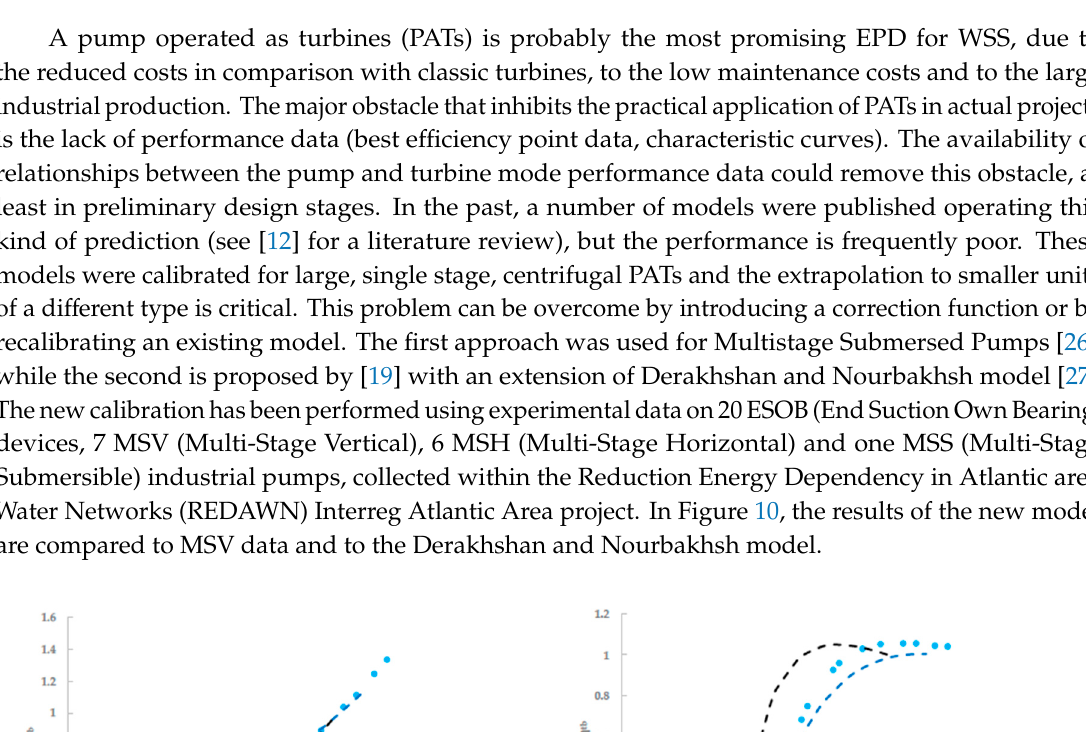
Figure 9. Green Valve System [18].